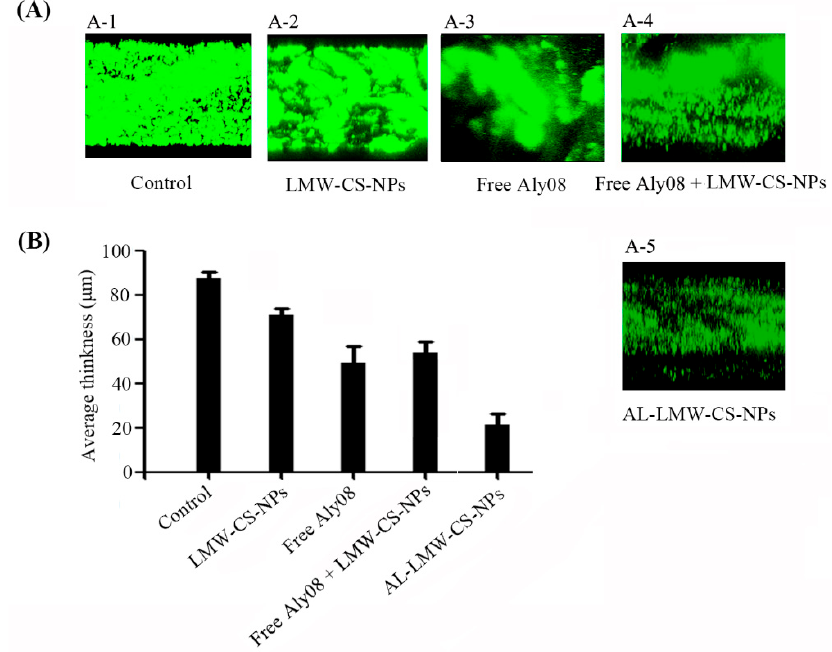
Figure 6. Prevention of biofilm formation in flow cell model. ( A ) Confocal laser scanning microscopy (CLSM) analysis of P. aeruginosa PAO1 biofilm formations in flow cell with media supplemented without ( A-1 ) and with LMW-CS-NPs ( A-2 ), free Aly08 ( A-3 ), free Aly08 + LMW-CS-NPs ( A-4 ) and AL-LMW-CS-NPs ( A-5 ); ( B ) Average thickness of P. aeruginosa biofilms after indicated treatment.